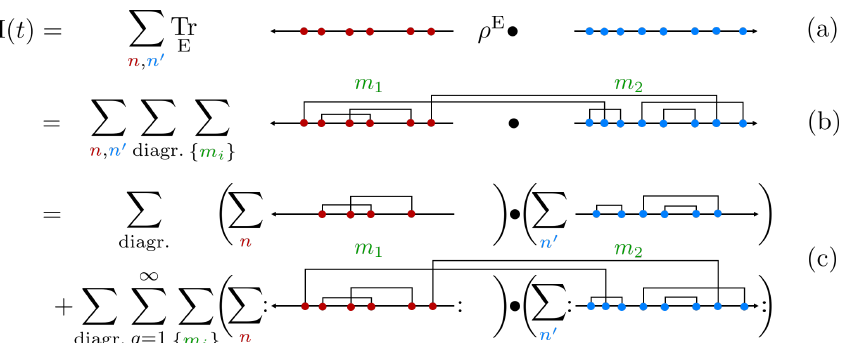
Figure 6: Reorganization of the standard real-time expansion in terms of left-right Keldysh diagrams [ cf. Fig. 5 ] : (a) Expansion of the unitary U [ U † ] into vertices − iV in red [ + iV in blue ] . (b) Evaluation of the trace gives both inter- and intra- branch contractions (c) Two-stage reorganization of (b). Stage 1: Sum up all intra- branch contractions separately (round brackets), but restrict the number of inter- branch contractions to q = 0,1,2,... fields and fix their modes m Sum up all contributions from modes m